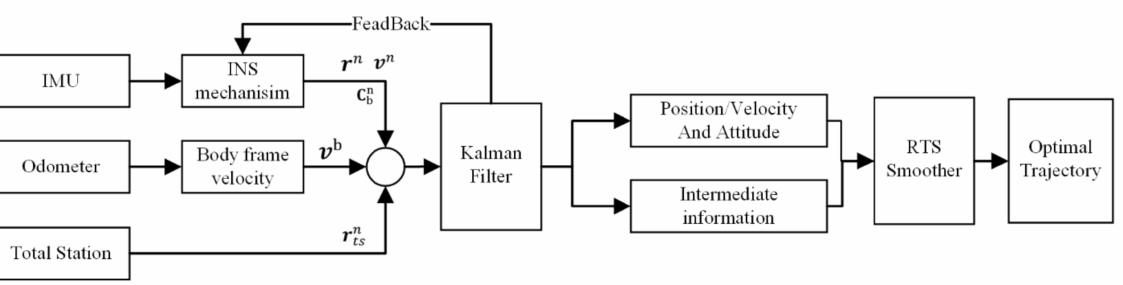
Figure 6. Trajectory estimation framework by fusion of INS, odometer and total station data. The state vector refers to a vector in a Kalman filter describing the system